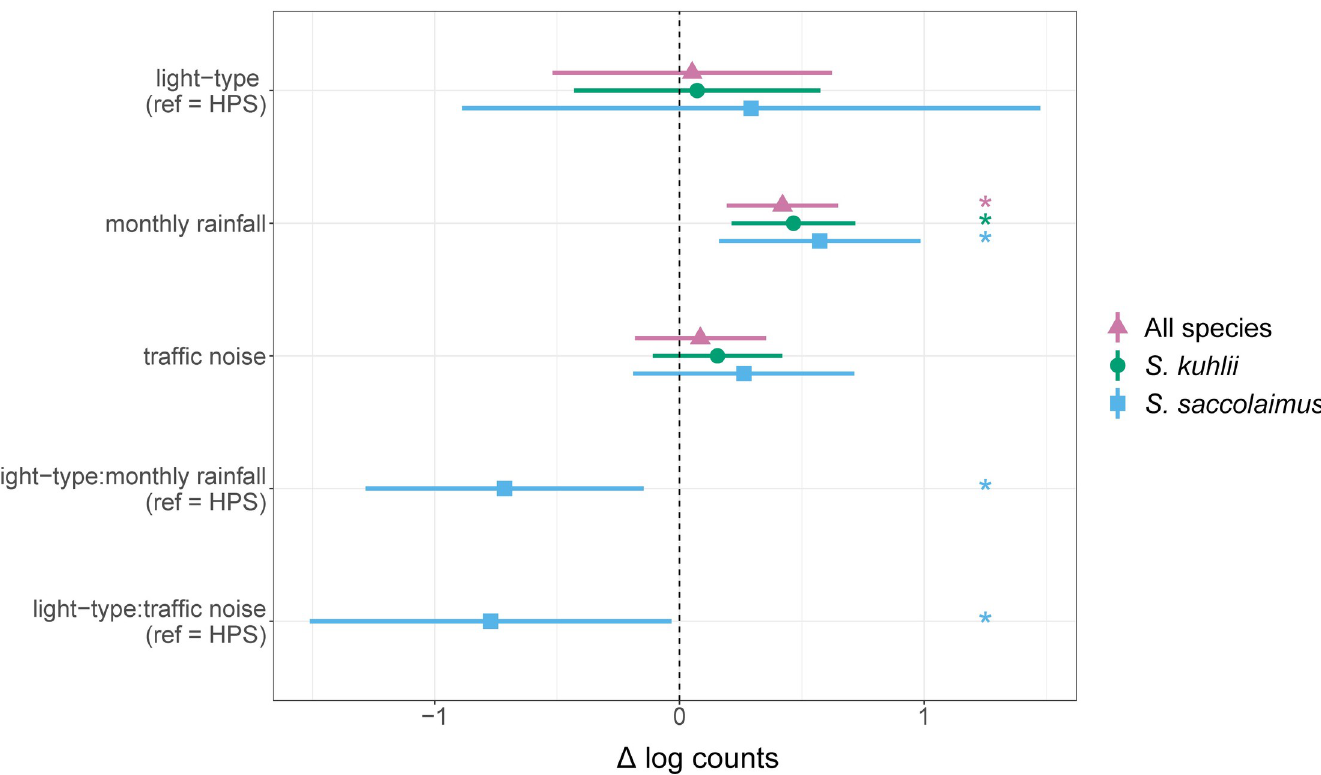
Fig 2. Effects of variables retained in the final GLMM model on log counts of bat passes for: All species, Scotophilus kuhlii , Saccolaimus saccolaimus . Dots are point estimates, with whiskers showing the 95% confidence interval. Asterisks beside dot-whiskers indicate significant effects. The reference level for light type was HPS (i.e., the change indicates the change when moving from an HPS to a LED street). Monthly rainfall and traffic noise were normalised to help with model